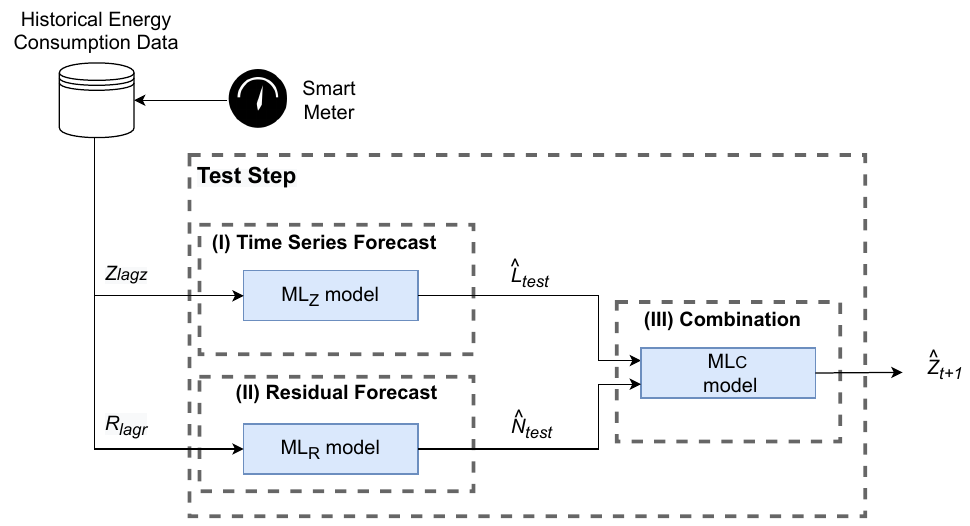
Figure 2. Diagram of the test step of the